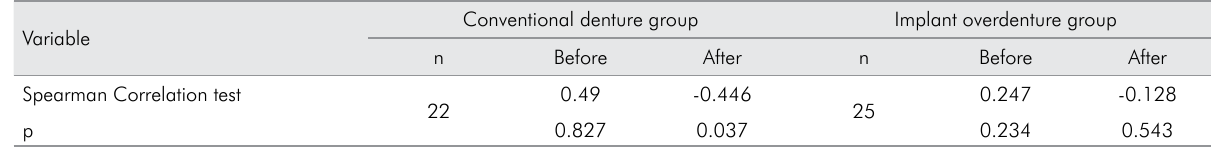
Table 4. Correlation between OHIP-Edent and masticatory efficiency before and after three months rehabilitation. Variable Before After Before